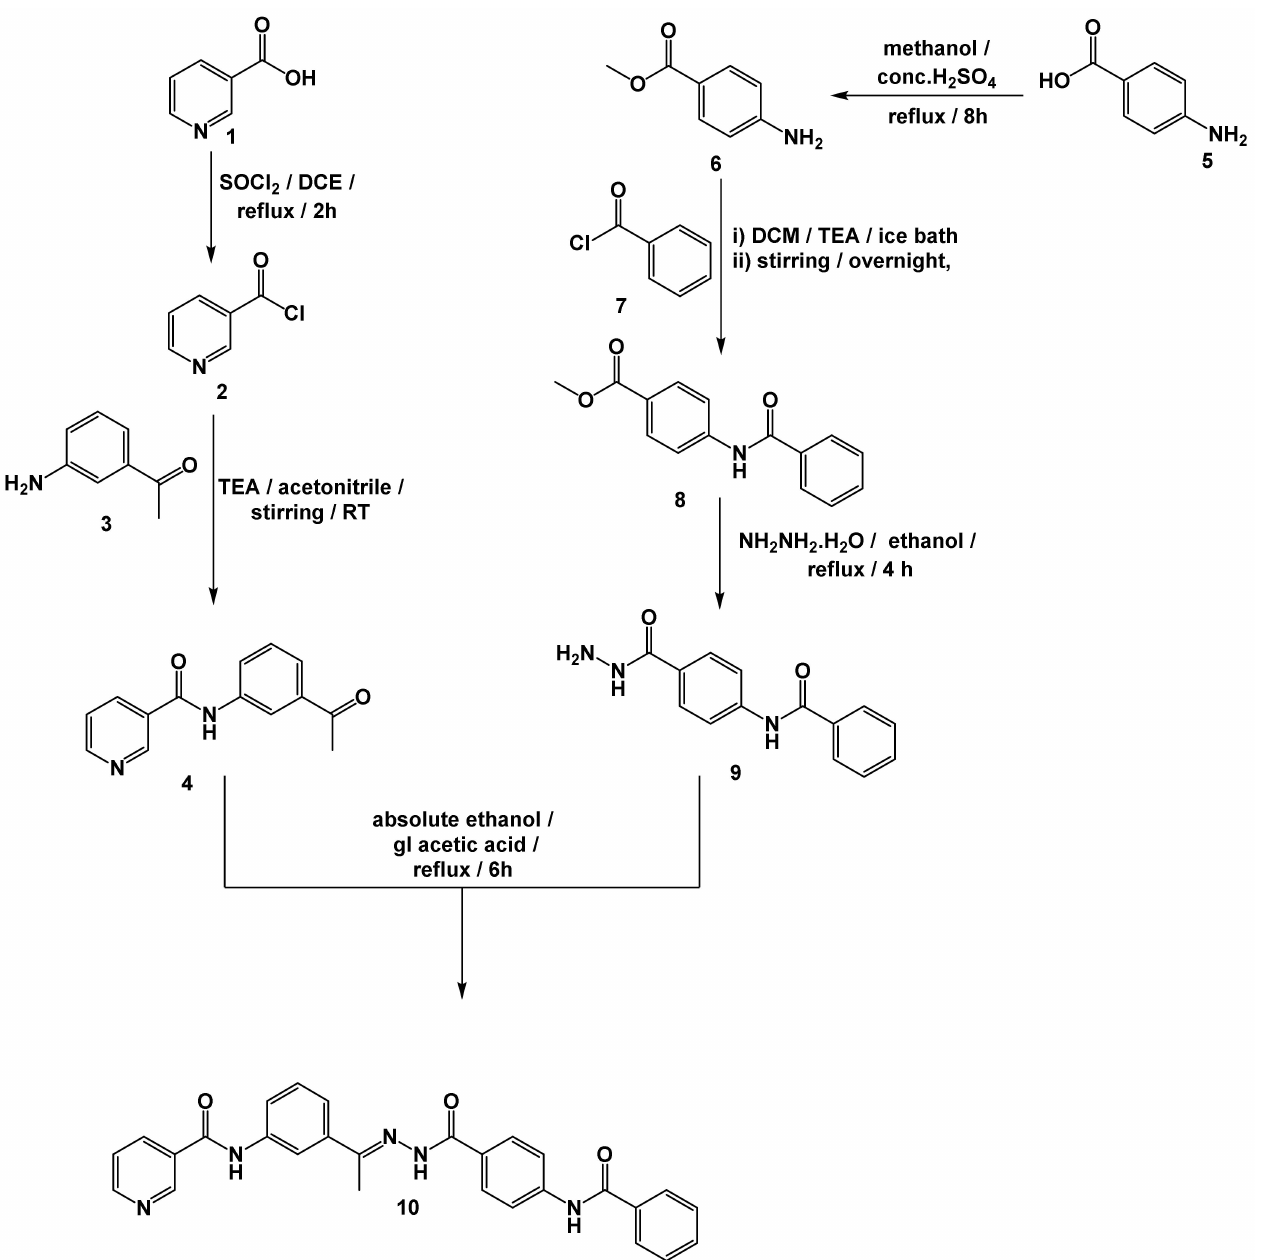
Scheme 1. General procedure for the synthesis of target compound 10